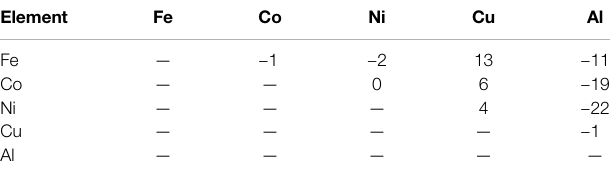
TABLE 2 | Mixing enthalpy of atomic pairs (kJ mol − 1 ). Element Fe Co